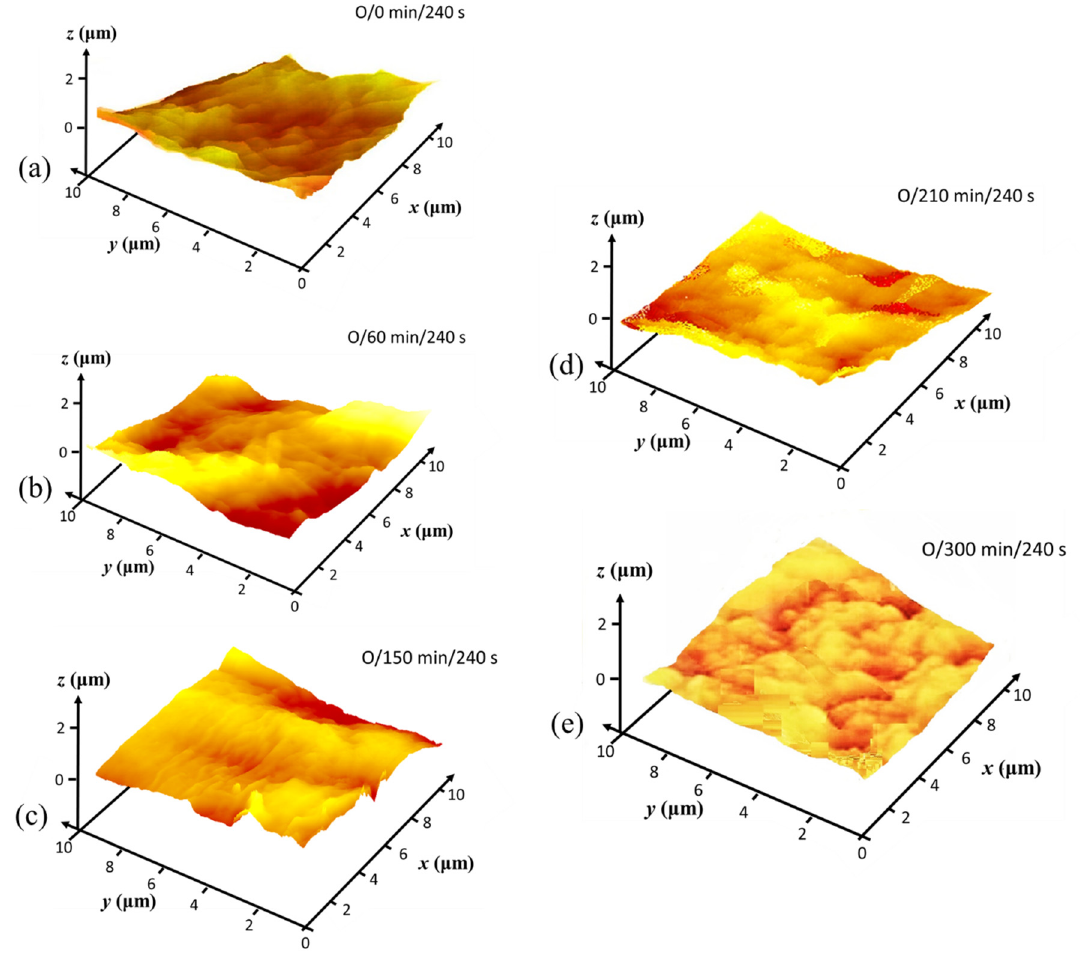
Figure 13. AFM surface profile plots showing the impact of extended oxygen plasma exposure (240 s) in balance with the initial progressively improved smoothness after enzymatic pretreatment: ( a ) 0 min, ( b ) 60 min, ( c ) 150 min, ( d ) 210 min, and ( e ) 300 min pretreatment, respectively.